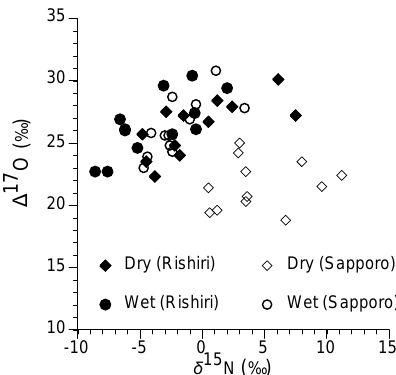
Figure 5. Correlations of δ 15 N and (cid:49) 17 O values of nitrate in wet and dry deposition at Rishiri and Sapporo. Dry deposition at Rishiri: slope = 0.57 (95% confidence interval = 0.15–0.79), r = 0.70, p = 0.01, n = 12; wet deposition at Rishiri: slope = 0.74 (95% confidence interval = 0.43–0.97), r = 0.73, p =